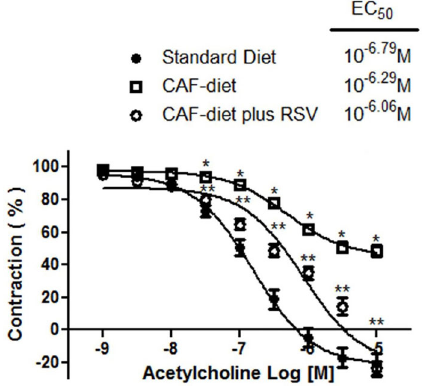
Figure 1. Concentration-dependent relaxation induced by 10 – 9 – 10 – 5 M acetylcholine on endothelium-intact rat aortic